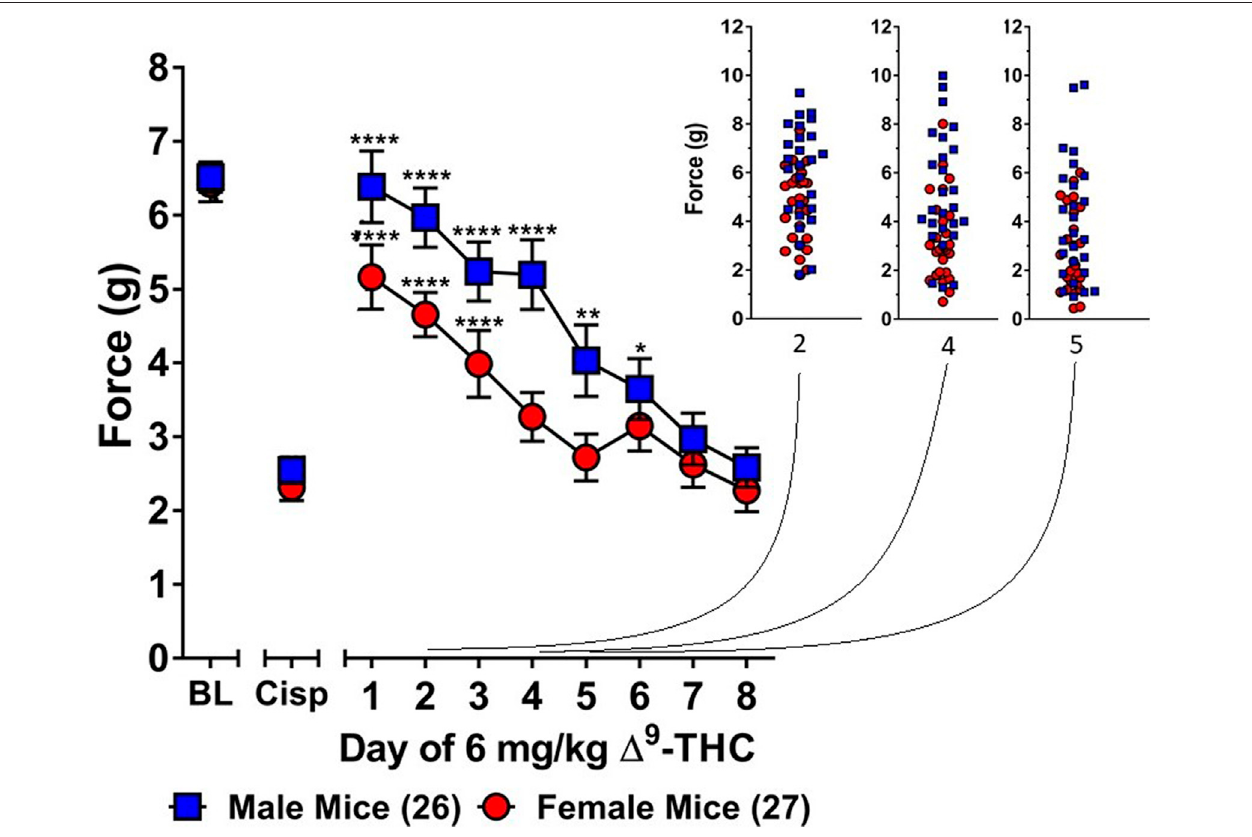
FIGURE2| Developmentoftolerancetotheanti-allodyniceffectsof6 mg/kgof Δ 9 -THCinfemaleandmalemice.Tolerancetotheanti-allodyniceffectsof6 mg/kg Δ 9 -THCwasdetermined infemale(redcircles)andmale(bluesquares)micecollapsedacrossgenotype.Micewereassessed usingthevonFreyassayfortheamountof force (in grams) required to elicit a paw withdrawal response 60 min following treatment with 6 mg/kg Δ 9 -THC. BL represents the pre-cisplatin baseline and CISP the post-cisplatin baseline. Error bars represent the mean ± SEM. Each mouse was tested in triplicate and those values averaged to determine a single value for each mouse each day oftesting. Datawere analyzed usingatwo-way ANOVAs withBonferronipost-hoc tests. [* p < 0.05; ** p > 0.01; *** p < 0.001; ****p < 0.0001; compared to the post-cisplatin baseline]. Sample sizes for each group (shown in parentheses) 26 male (13 WT; 13 KI) and 27 female (13 WT; 14 KI) mice.